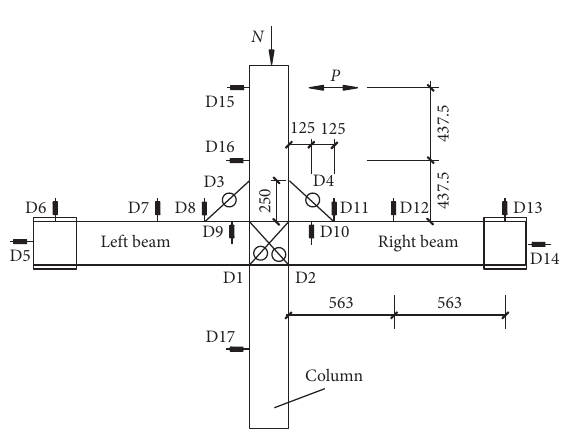
Figure 5: Layout of LVDTs (unit: